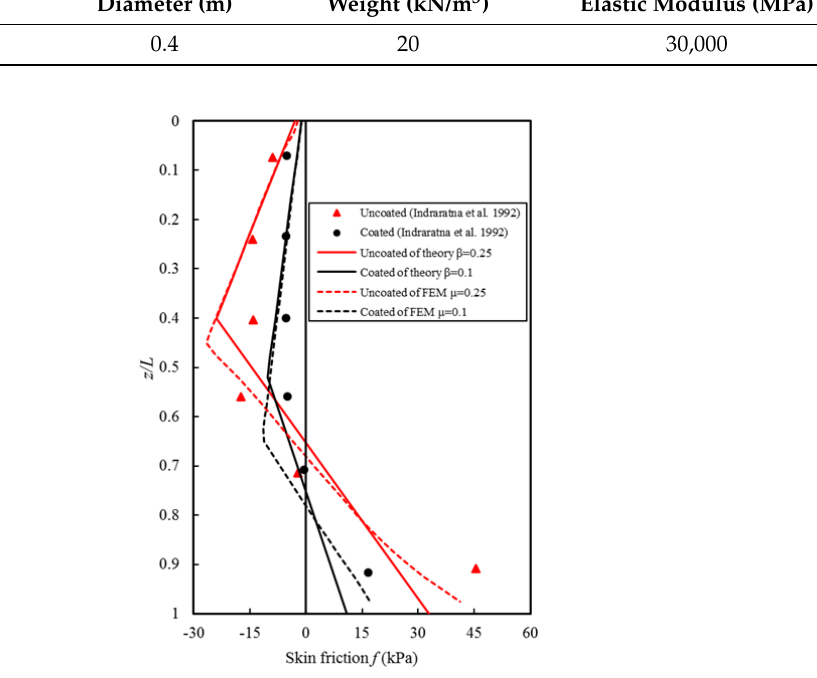
Table 3. The parameters of pile.